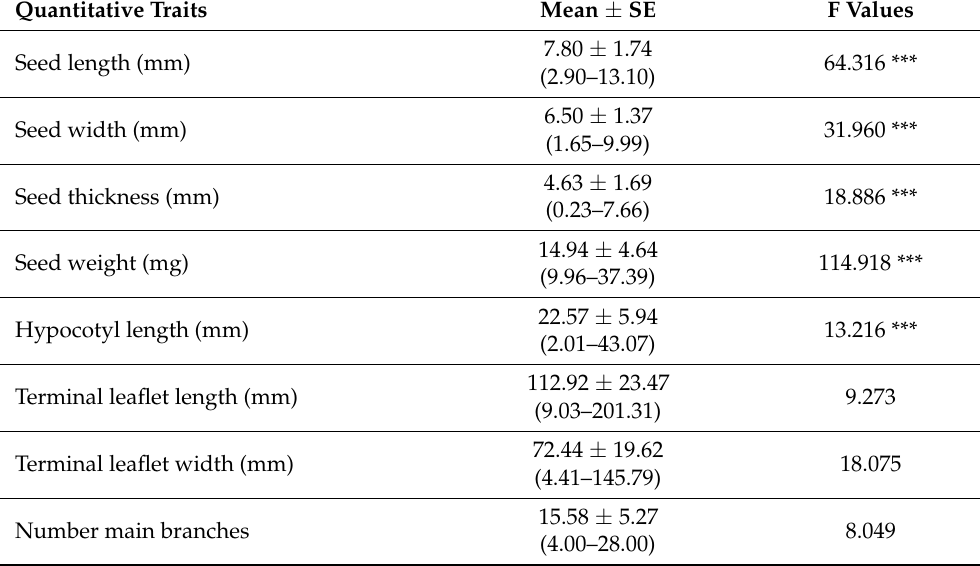
Table 2. Quantitative traits of Vigna unguiculata across 610 specimens measured. Values indicate mean ± SE and maximum and minimum range values in parentheses found across the landraces studied. Comparisons between landraces were performed with one-way ANOVA. *** p < 0.001. Quantitative